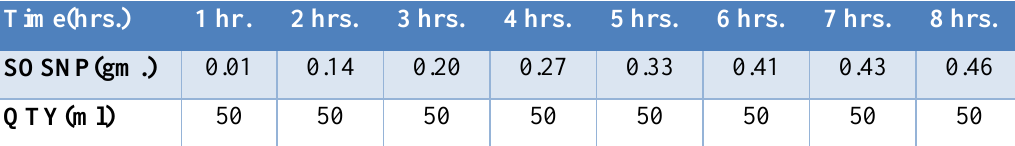
Figure, 2: Silver nanoparticles a diagram showing the absorbent rates of SOSNPs at different times. Table ,2: Amount of the Silver nanoparticles (SOSNP) (g.) that synthesized by Salvia officinal's extract (ml)